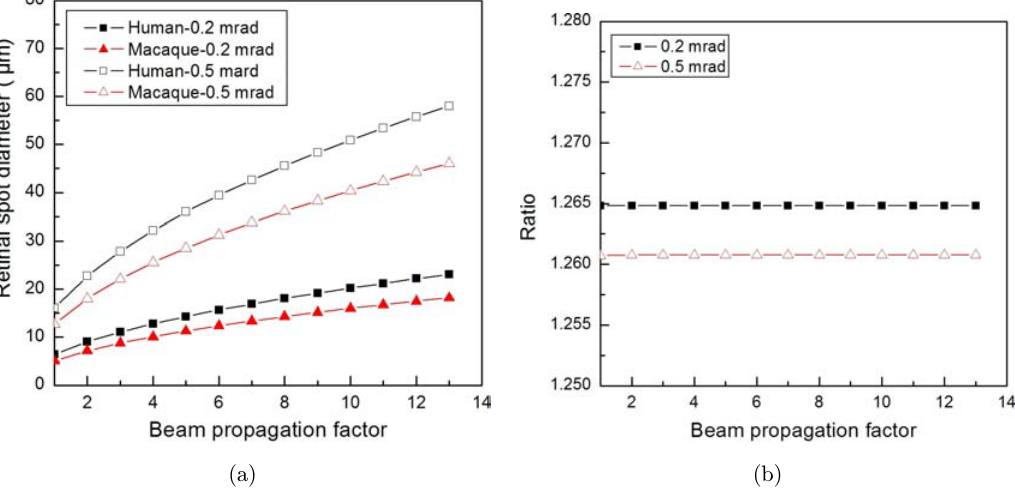
Fig. 7. Retinal spot diameter versus beam propagation factor for human and macaque (a) and the ratio between the two species (b). Parameters are same with Fig. 5.